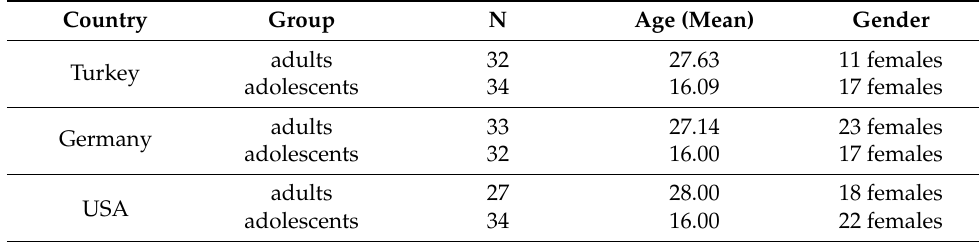
Table 2. Participant